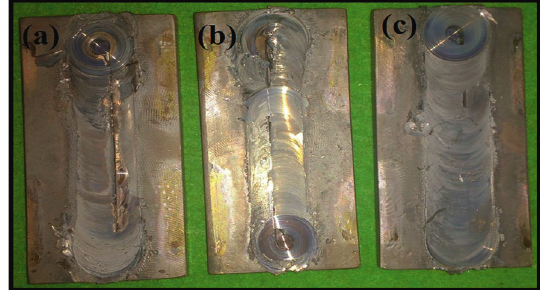
Figure 3: Defects that occurred during FSP trial: (a) tunnel defect; (b) tool dragging; (c) crack formation.